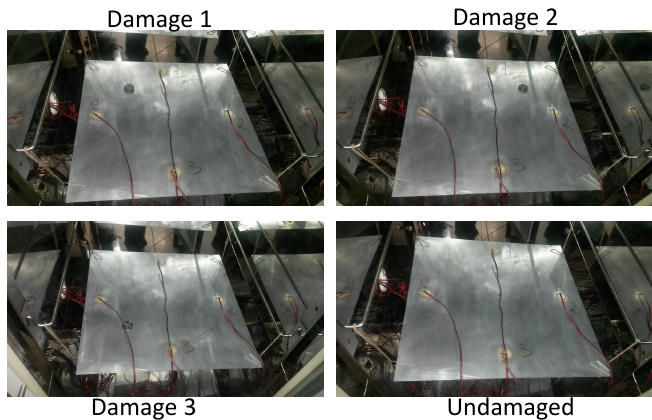
Figure 10. The plate in the climate